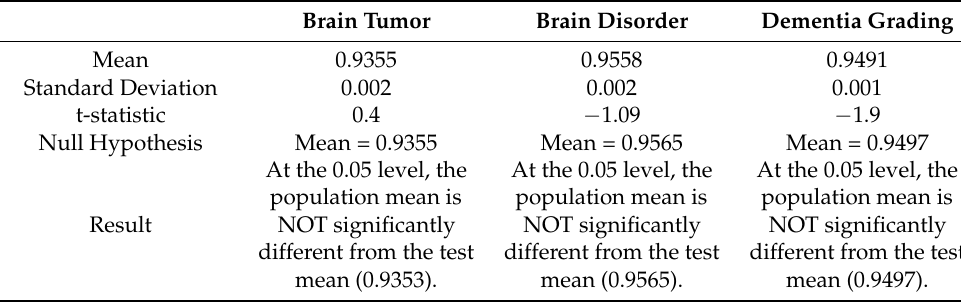
Table 7. Statistical significance test